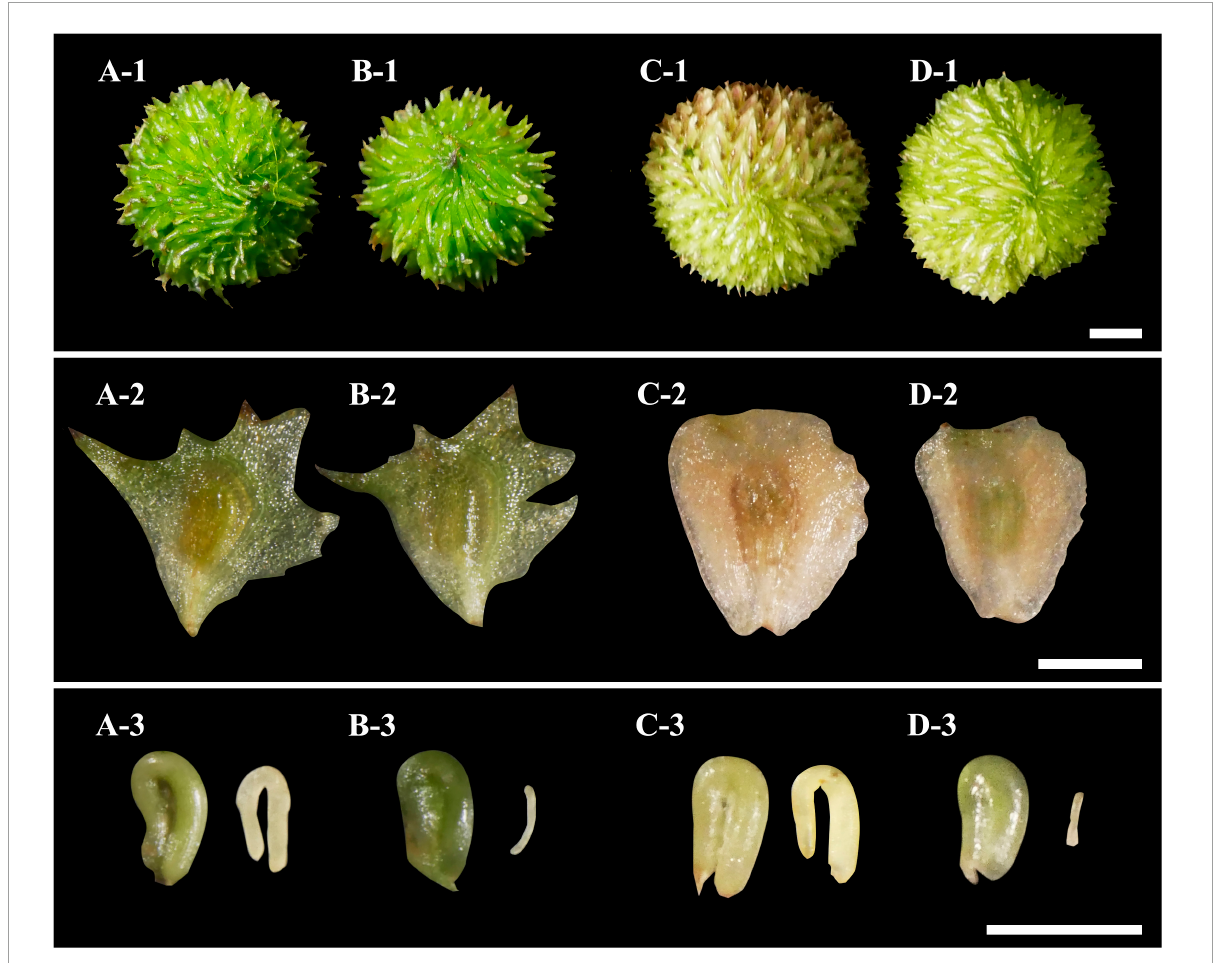
FIGURE3 Aggregated fruits and achenes resulting from conspecific pollination and reciprocal crosses of Sagittaria pygmaea and S. trifolia , as well as images of mature seeds and embryos obtained from inside the conspecific-pollinated and interspecific-pollinated fruits. All crosses are female × male. (A) S. pygmaea × S. pygmaea. (B) S. pygmaea × S. trifolia. (C) S. trifolia × S. trifolia. (D) S. trifolia × S. pygmaea. 1, 2, and 3 represent aggregate fruits, achenes, and seeds and embryos, respectively. Scale bar: 2 mm.